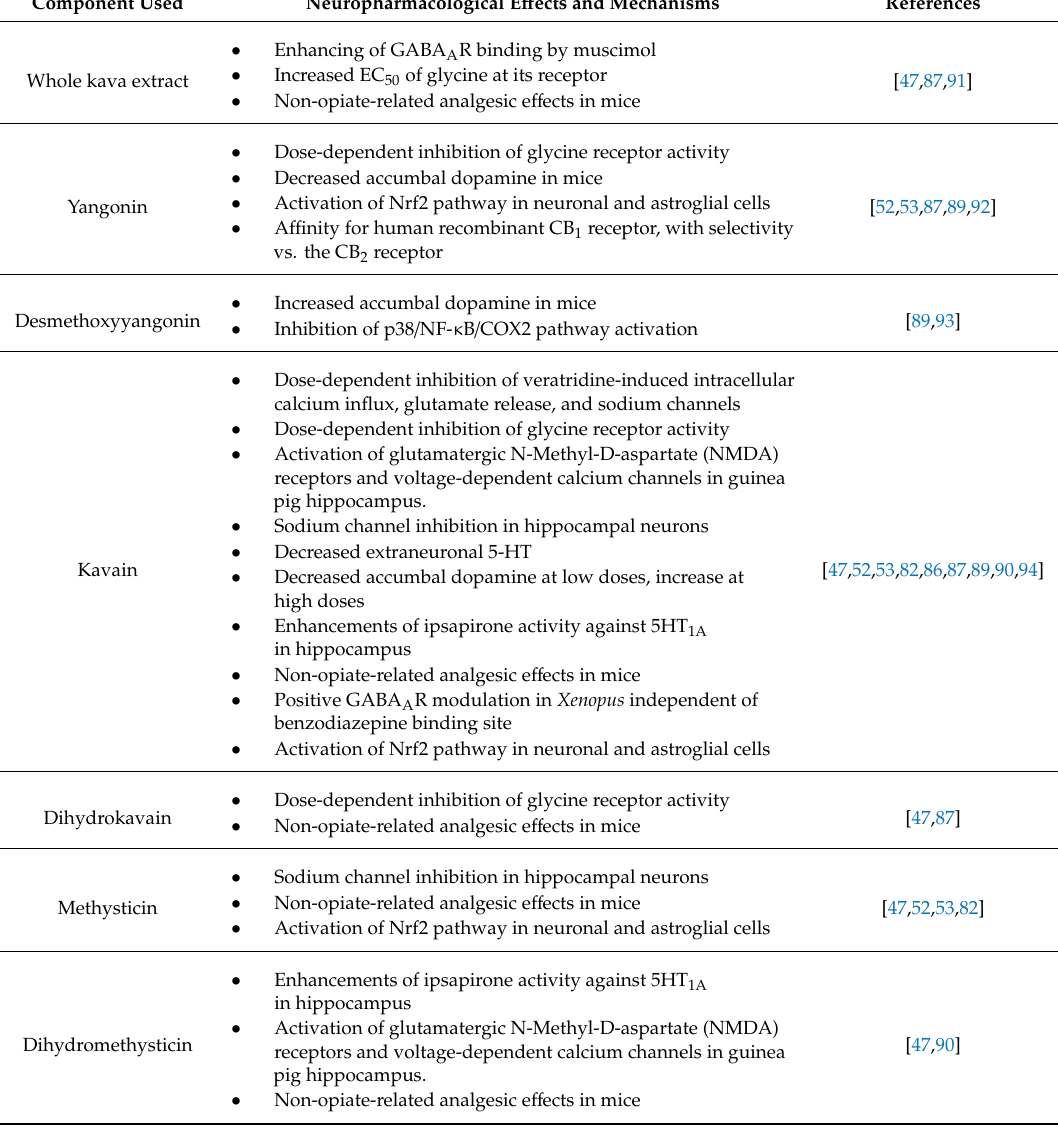
Table 4. Summary of neuropharmacological e ff ects and